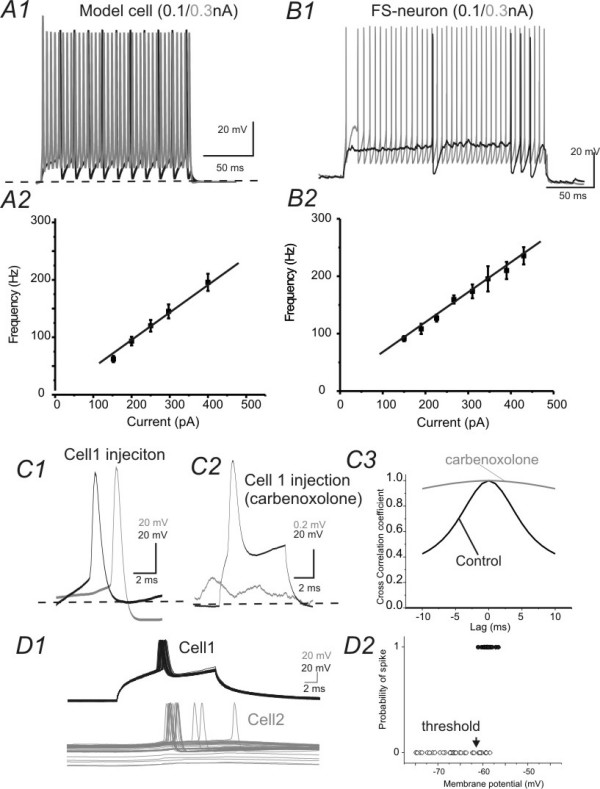
Simulation and electrophysiological recordings of GJ-mediated responses in model and real FS pairs. A1 & B1)Repetitive spikes were evoked in a model cell (A1) and a real FS interneuron (B1). Black and gray traces were evoked by currents of 100 & 300 pA, respectively. A2& B2) F-I (frequency-current) plot of the model FS neuron (A2) and a real FS cell (B2). C) Presynaptic (black) and postsynaptic responses in a GJ coupled FS pair recorded in slice in the absence (C1) and presence of GJ inhibitor carbenoxalone (C2). C3: Spike synchronization is strong in C1 and weak in C2. D) Representative traces (D1) and spike probability plot (D2) showing that the spike transmission depends on the membrane potential of the postsynaptic cell.